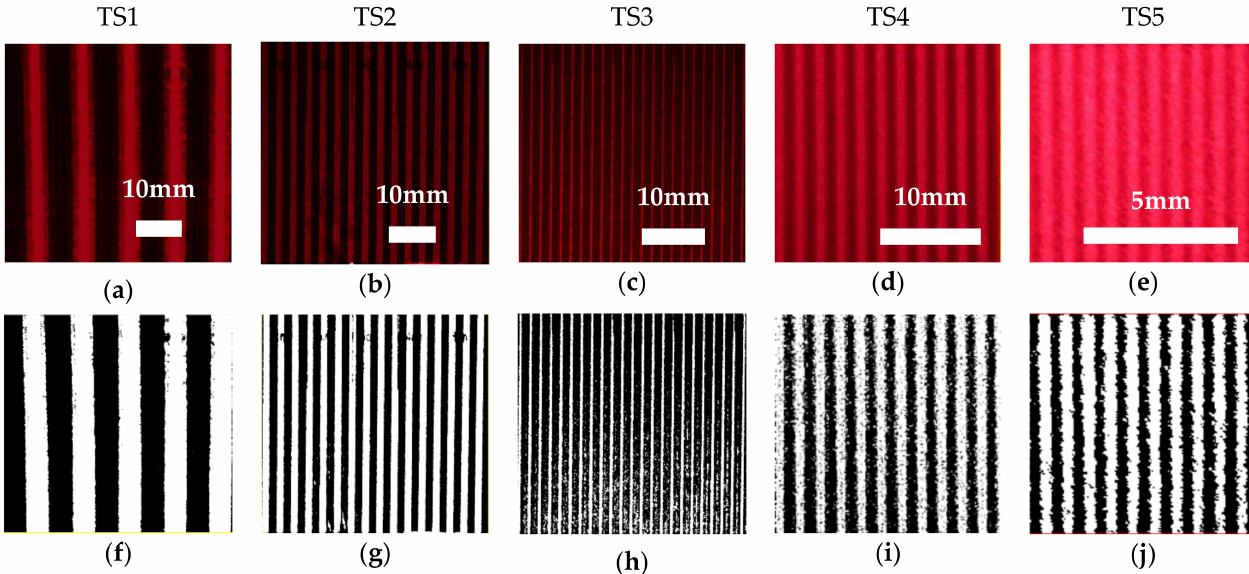
Figure 3. Experiment setup for measuring ( a ) reflection and ( b ) transmission samples. SF, spatial light filter; G, Ronchi grating; TS, test sample; OS, observation screen.